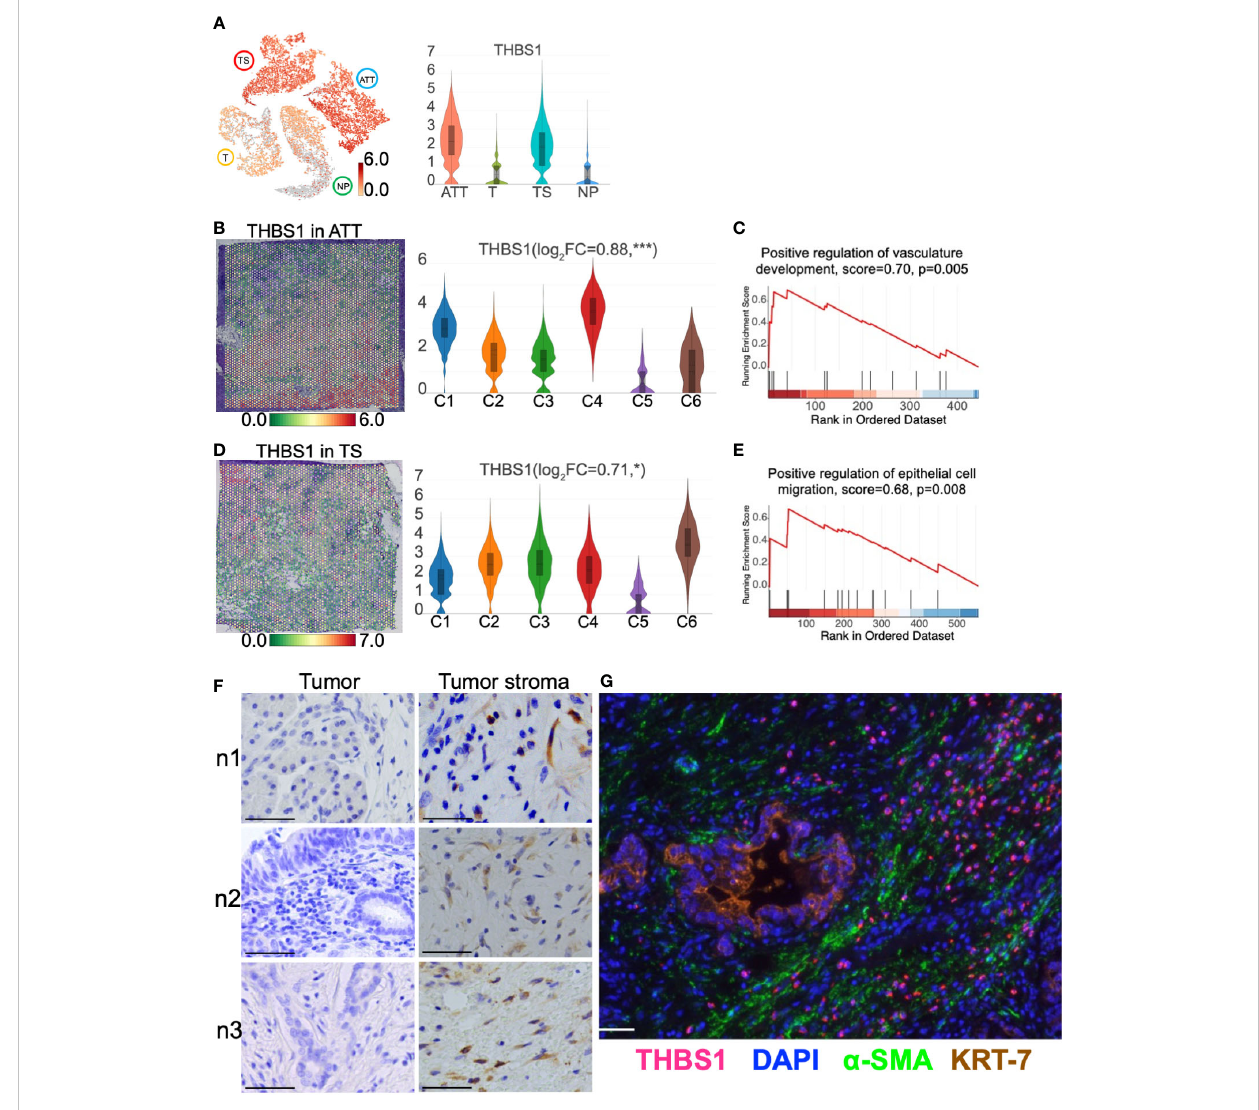
FIGURE 8 THBS1 location and distribution in pancreatic tissues. (A) The distribution and level of THBS1 across the normal pancreas (NP), adjacent tumor tissue (ATT), tumor (T), and tumor stroma (TS). (B) The distribution and level of THBS1 in ATT. (C) ATT-C4 genes were enriched in “ Positive regulation of vasculature development ” by gene set enrichment analysis (GSEA). (D) The distribution and level of THBS1 in TS. (E) TS-C6 genes were enriched in “ Positive regulation of epithelial cell migration ” by GSEA. (F) Immunohistochemical staining of THBS1 in the tumor (left column) and tumor stromal tissues (right column) from three pancreatic ductal adenocarcinoma tissue samples. (G) Multiple immuno fl uorescence staining in tumor tissue. The bar plots and the vertical coordinate of the violin plots indicates the log 2 FC of the gene expression value of each cluster versus the average gene value. Scale bar = 50 m m. *Represents a statistical P-value<0.05, and *** represents a statistical